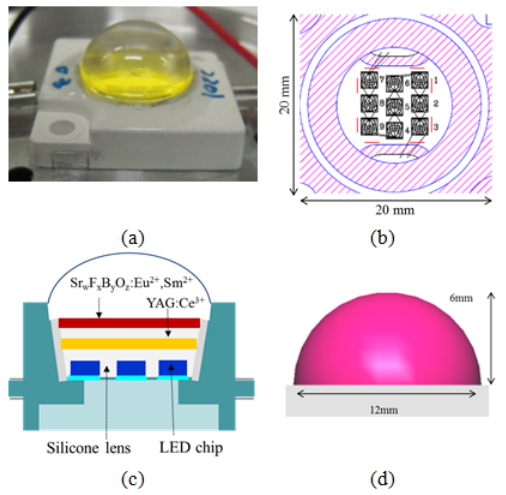
Fig. 1: Photograph of WLEDs structure: (a) Actual WLEDs, (b) Bonding diagram, (c) Illustration of pc-WLEDs model, (d) Simulation of WLEDs using LightTools commercial software.